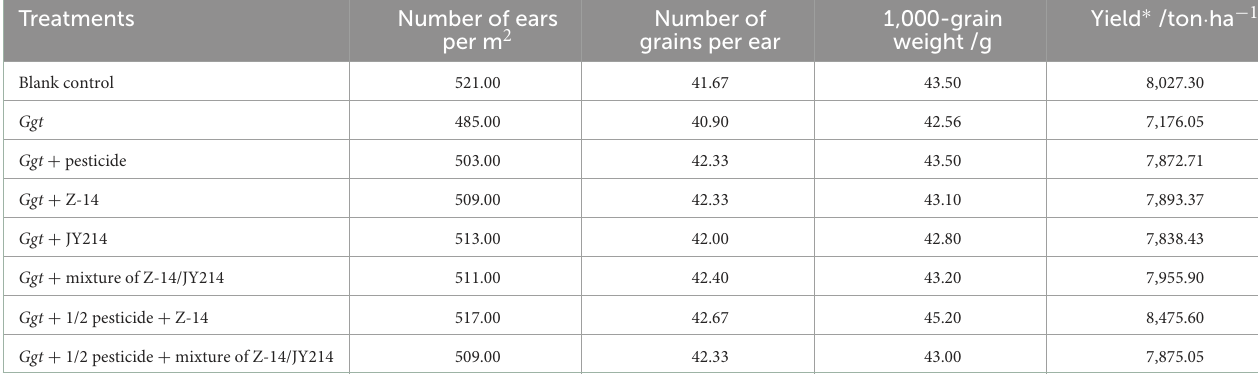
TABLE 7 Effects of pesticide, Z-14, JY214, and their combinations on yield of Ggt -infected wheat in the field treatments.